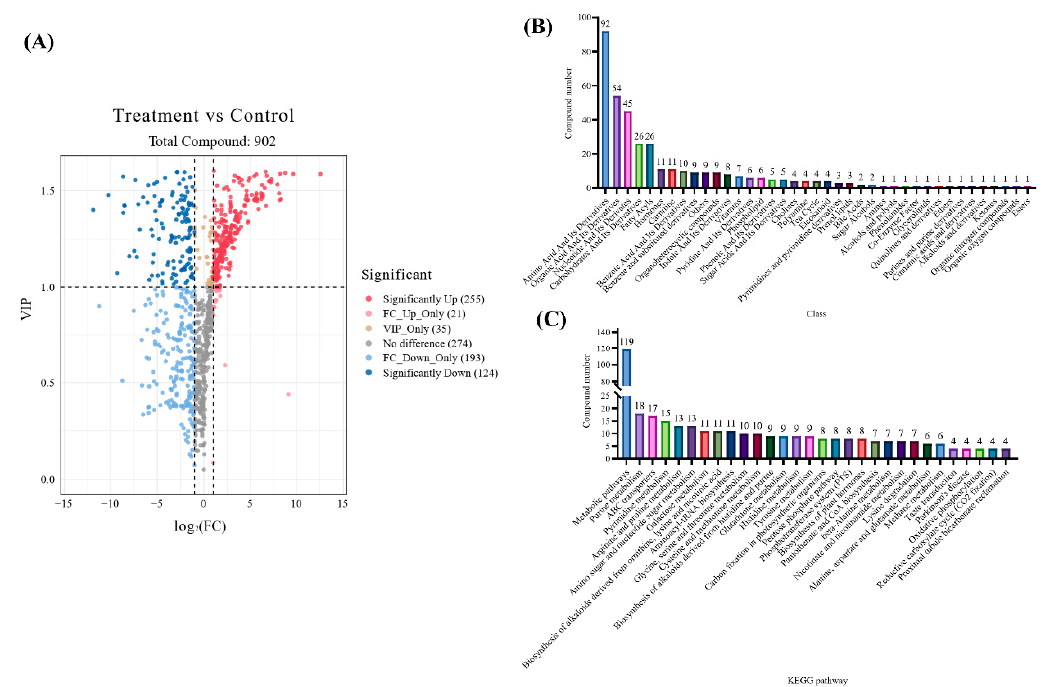
Figure 3. Metabolome analysis reveals the differently changed compounds with 9-phenanthrol in M. oryzae . ( A ) The volcano diagram of identified metabolites under 9-phenanthrol treatment. The class ( B ) and KEGG pathways ( C ) of significantly different metabolites of M. oryzae under 9-phenanthrol treatment.